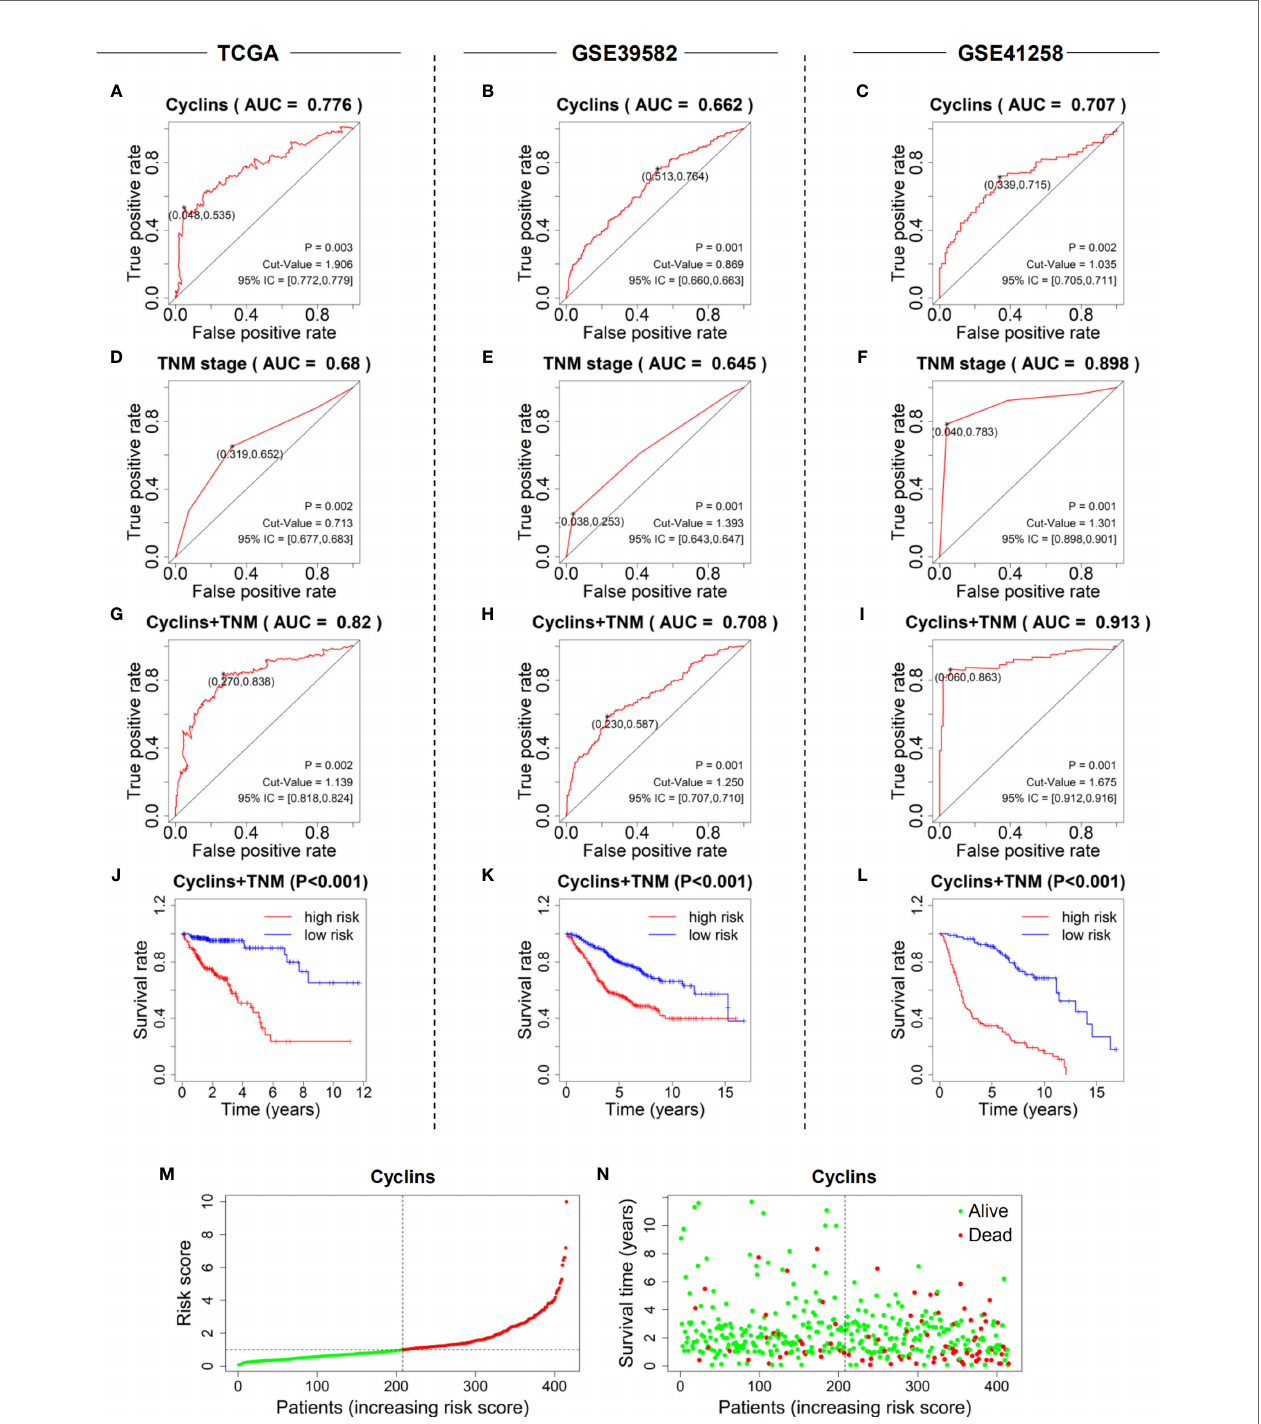
FIGURE 7 | Prediction models to predict the prognosis of patients with colon cancer in the three datasets. (A – C) Five-year ROC curves of the prediction models based on the expression of 24 cyclin genes. (D – F) Five-year ROC curves of the prediction models based on patient TNM stage. (G – I) Five-year ROC curves of the prediction models integrating 24 cyclin genes and TNM stage. (J – L) Survival curves showing the survival difference between high- and low-risk patients. The risk scores were calculated by the prediction models integrating 24 cyclin genes and TNM stage. (M) Risk score distribution of the patients in ascending order and divided into low- (green) and high-risk (red) in TCGA dataset. (N) Survival time and status of the patients in order of increasing risk scores in TCGA dataset. Red and green dots represent dead and alive,